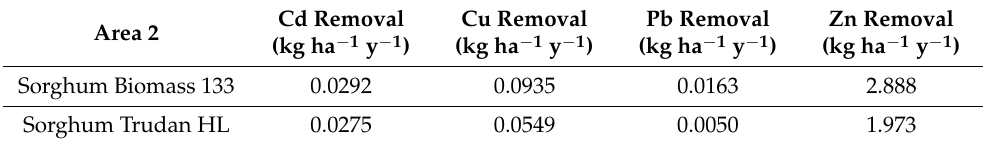
Table 5. Annual Cd, Cu, Pb, and Zn removal for the two cultivars after the biomass harvest. Cd Area 2